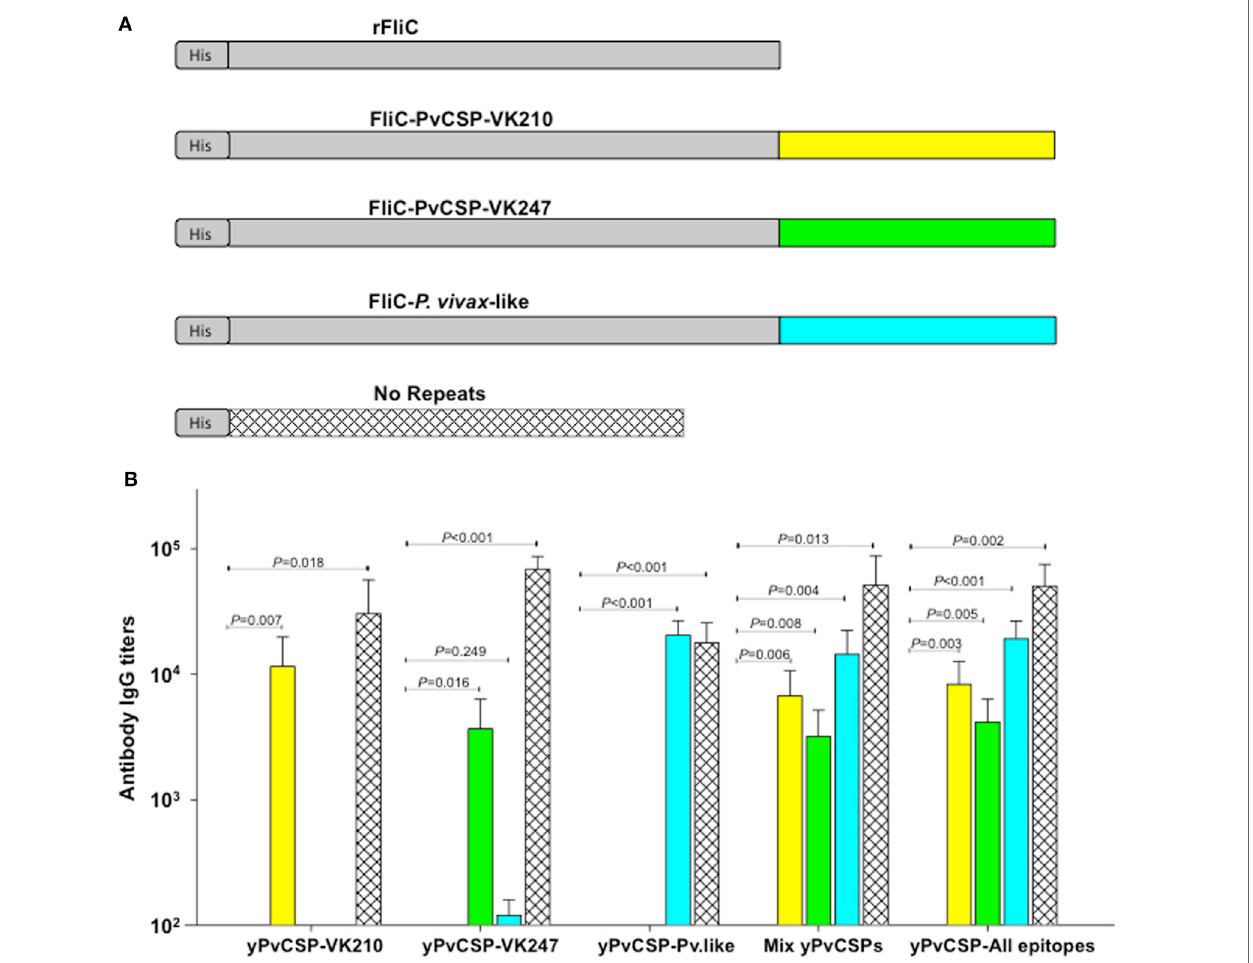
FigUre 4 | Specificity of IgG antibody in mice immunized with Plasmodium vivax circumsporozoite protein (CSP) recombinants. (a) Schematic representation of recombinant proteins used as a substrate bound to the plates in the ELISA assay. (B) C57BL/6 mice were immunized s.c. with the purified proteins in the presence of the adjuvant Poly(I:C) according to the timeline described in Figure 3a . The specificity of IgG antibody serum titers toward rFliC, FliC-PvCSP-repeats and No repeats proteins were analyzed by ELISA in sera of mice from groups 2 to 6 described in Figure 3B . The results are expressed as mean ± SD ( n = 6 animals/ group). P values are indicated. Differences were considered statistically significant when P <